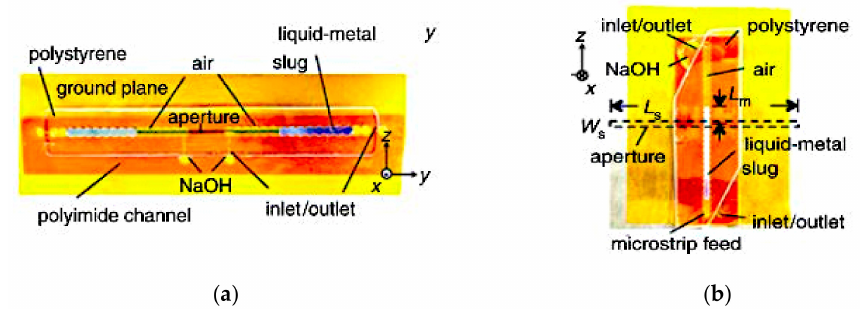
Figure 4. Fluidic slot antenna. ( a ) Liquid metal slugs in aperture. ( b ) Liquid metal slug in microstrip line